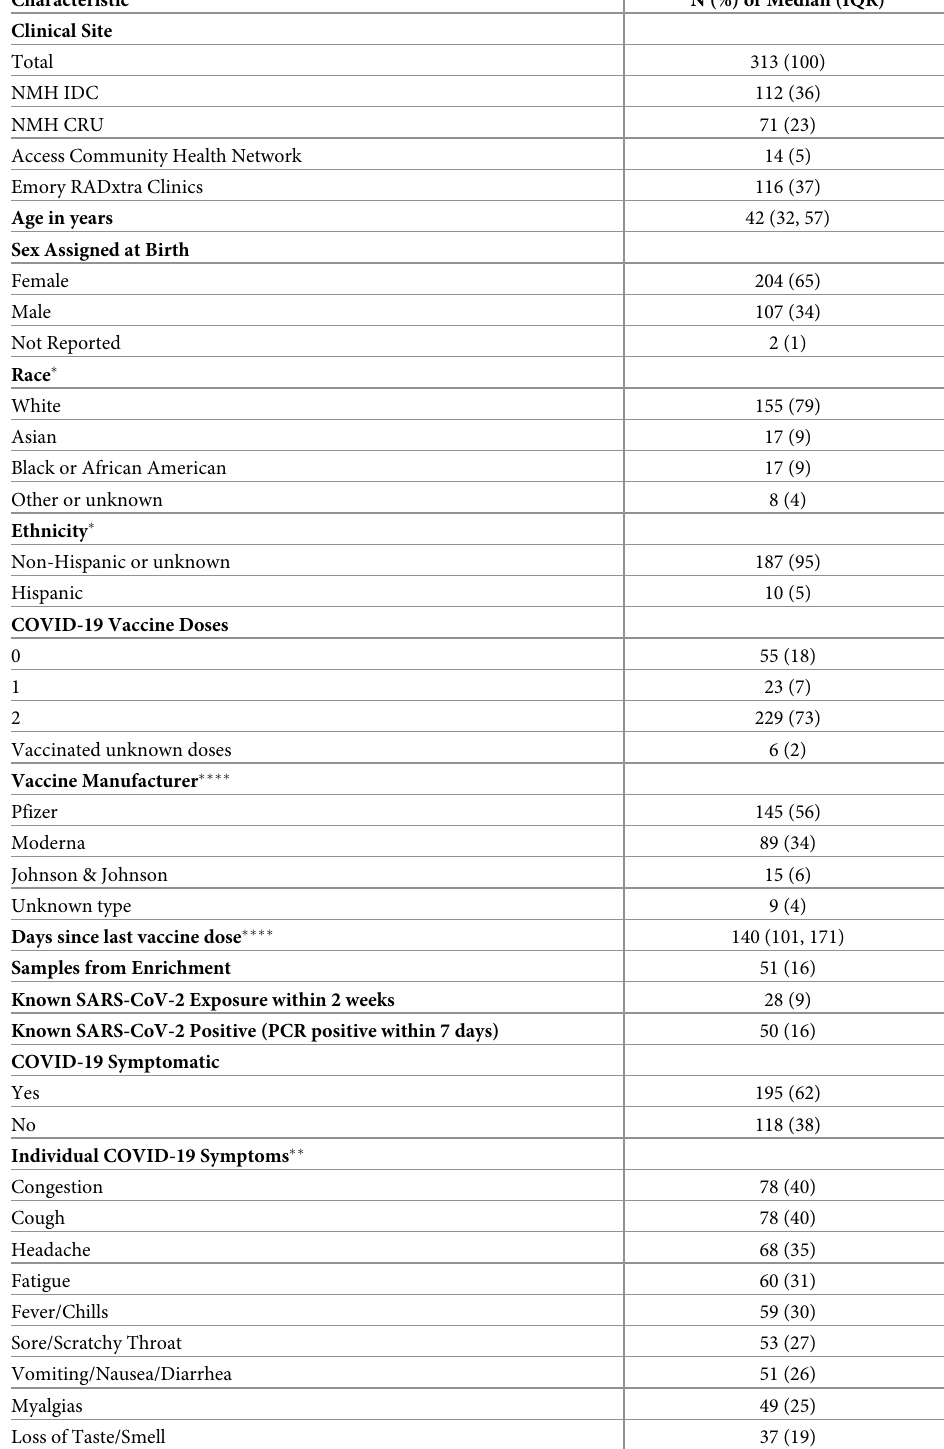
Table 1. Characteristics of 313 participants with a valid Diagnostic Analyzer for Selective Hybridization (DASH) SARS-CoV-2 PCR test